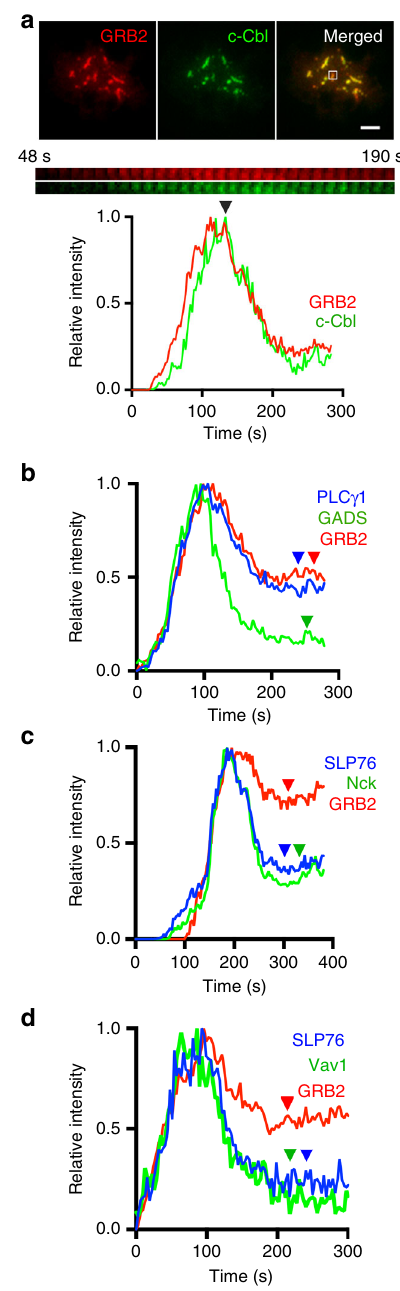
Fig. 4 Signaling domain disassociation coincides with c-Cbl recruitment and occurs at two distinct rates. a TIRF image of microclusters formed in Jurkat T cells activated on coverslip-bound anti-CD3 antibody at 21 °C were visualized using c-Cbl-YFP and GRB2-Apple. Time-lapse montage (middle) and relative intensity plot (bottom) of the boxed region in the top image shows decrease in GRB2 and c-Cbl signal coincident with peak c-Cbl recruitment (black arrowhead). Scale bar, 2 μ m. b – d Representative relative intensity plots of b PLC γ 1-CFP (blue), GADS-YFP (green), and GRB2-Apple (red), or c SLP76-CFP (blue), NCK-YFP (green), and GRB2-Apple (red), or d SLP76-CFP (blue), Vav1-YFP (green), and GRB2-Apple (red) at microclusters. The colored arrowheads indicate the fi nal intensity levels after disassociation of each corresponding signaling cluster component